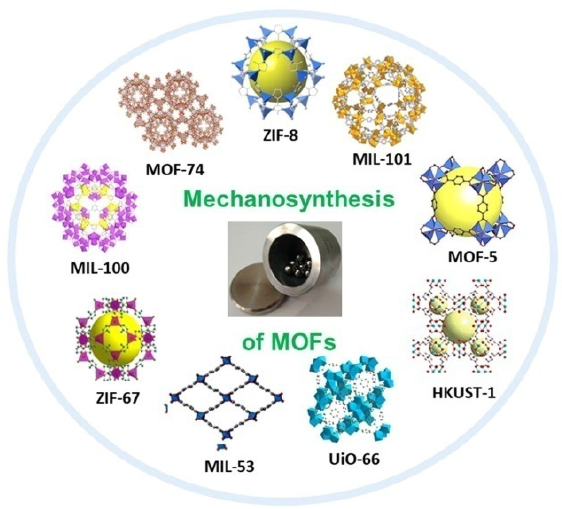
Figure 6. Different MOFs synthesized using the mechanochemical method [31]. Reproduced with permission.